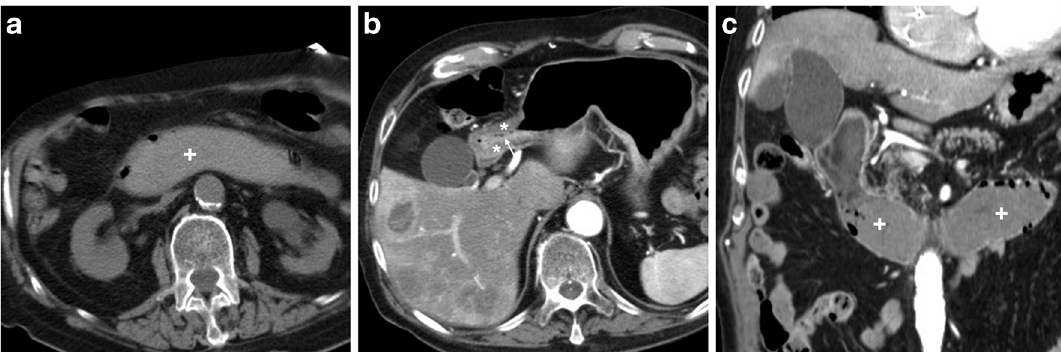
Fig. 8 In an elderly 84-year-old male with haematemesis and melaena, precontrast CT scans ( a ) showed dilated second, third and fourth duodenum filled by hyper attenuating fluid (+) consistent with recent haemorrhage. Arterial-phase CT acquisition ( b, c ) showed characteristic